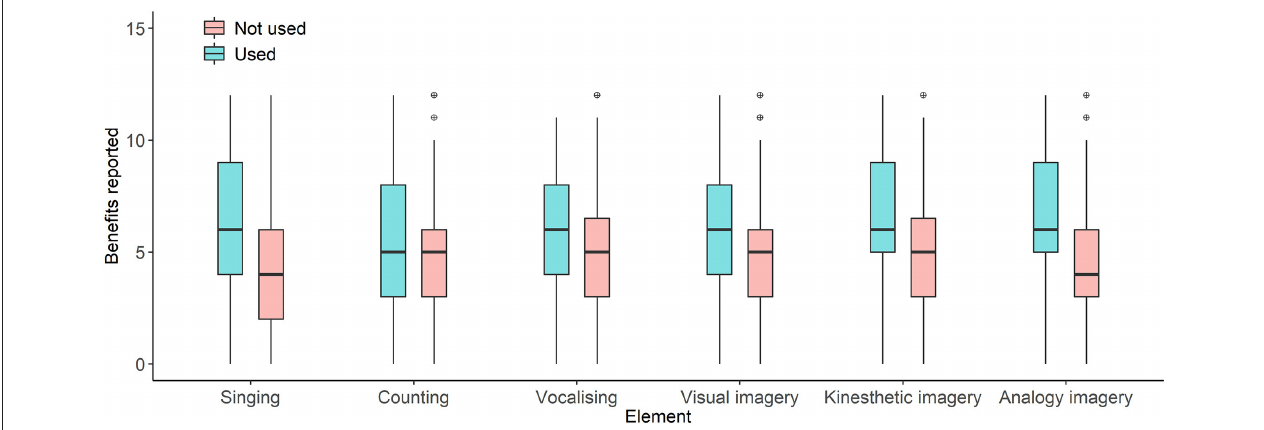
FIGURE 3 | Self-reported benefits in relation to the use of different strategies and cues during home-based dance participation. Boxes show medians with quartiles and dots represent outliers. All three types of imagery (visual, kinesthetic, and analogy/metaphor), as well as singing, were significantly associated with higher numbers of perceived